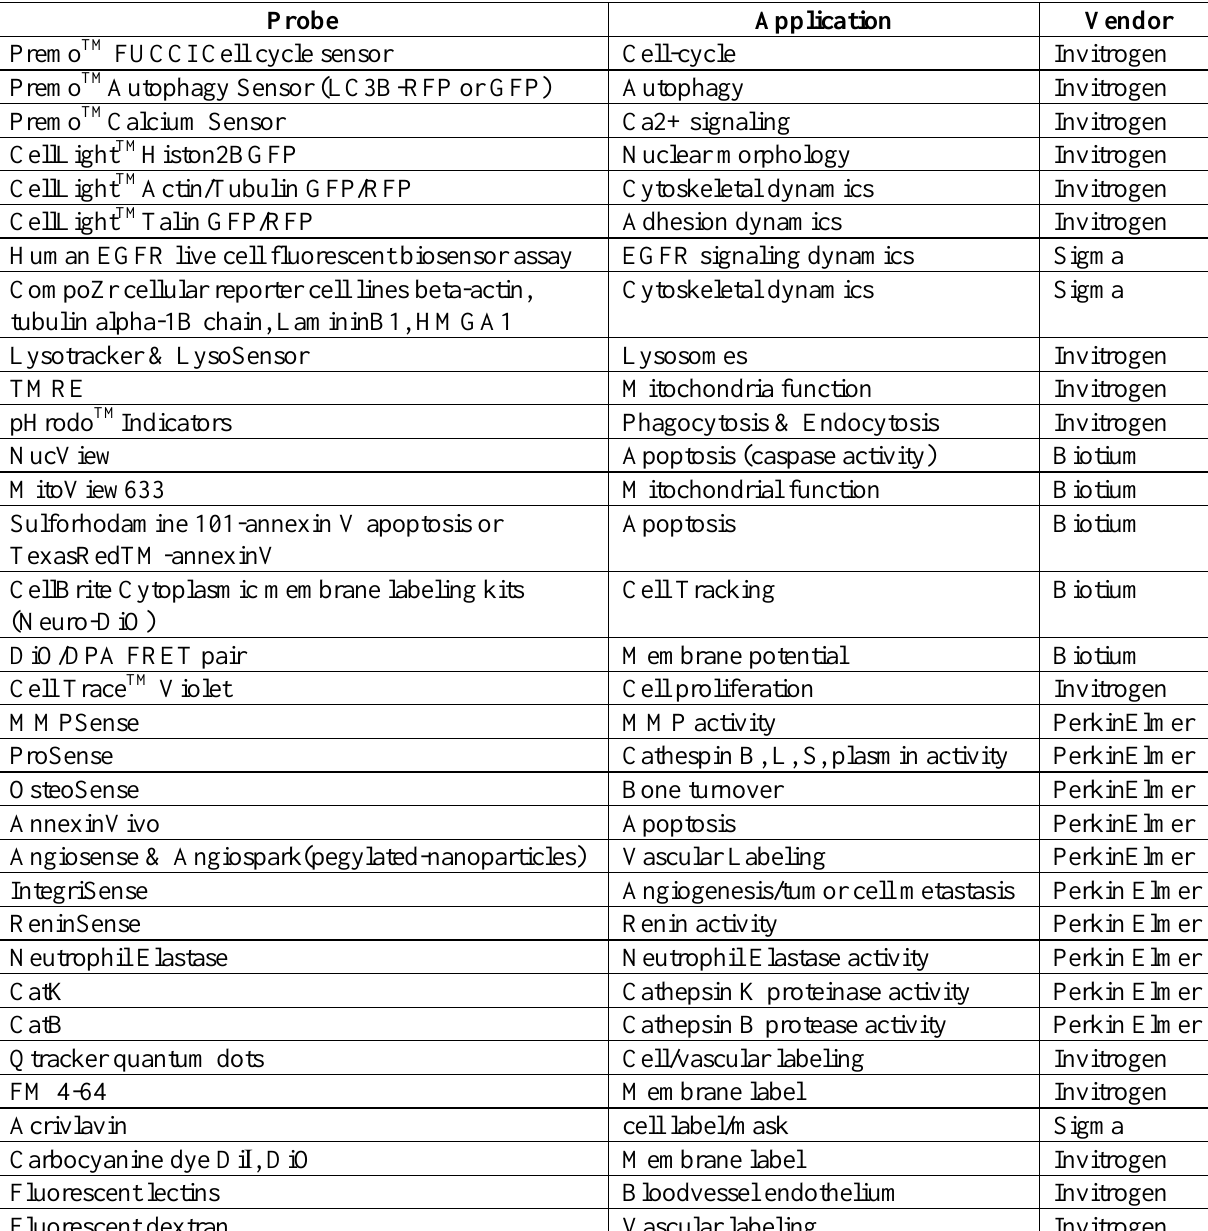
Table 1. Selected list of commercially available live cell imaging probes, applications and